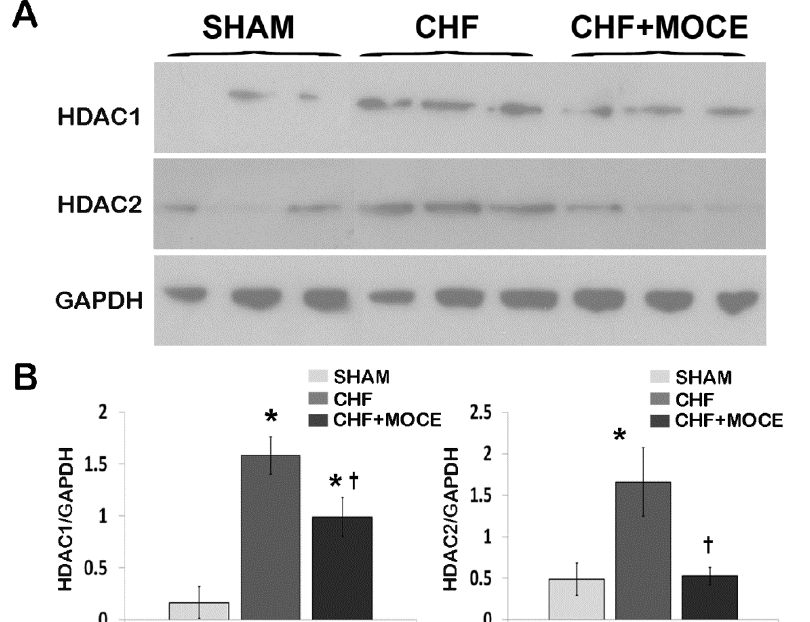
Figure 1. Mocetinostat reduced HDAC1 and 2 levels in CHF. ( A ) LV from sham, untreated and Mocetinostat-treated CHF hearts was lysed. Forty µg of protein was loaded and separated in 4%–12% Bis-Tris SDS/PAGE gel and blotted with HDAC1 and HDAC2 antibodies. GAPDH was used to normalize for loading ( n = 4); ( B ) Density analysis of blots was presented as arbitrary units in bar graphs. Error bars indicate SE. * , p < 0.05 compared to shams; †, p < 0.05 compared to untreated CHF; CHF, congestive heart failure; HDAC, Histone Deacetylase; MOCE,